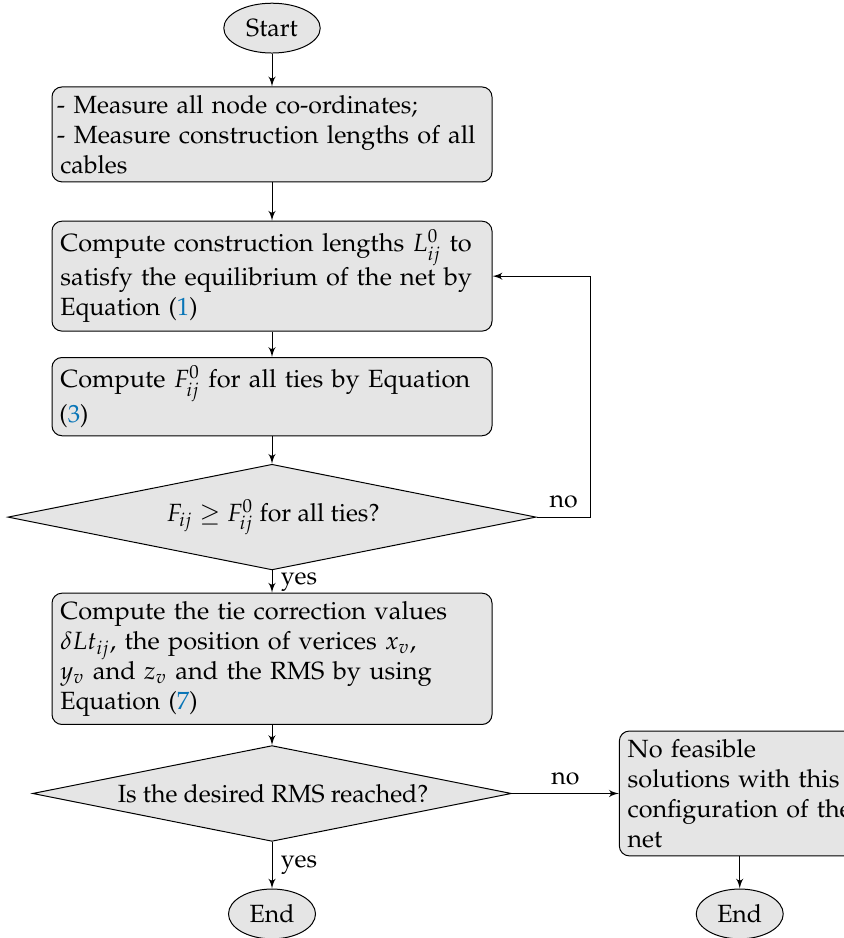
Figure 7. Flowchart for the algorithm of the proposed method. RMS, Root Mean